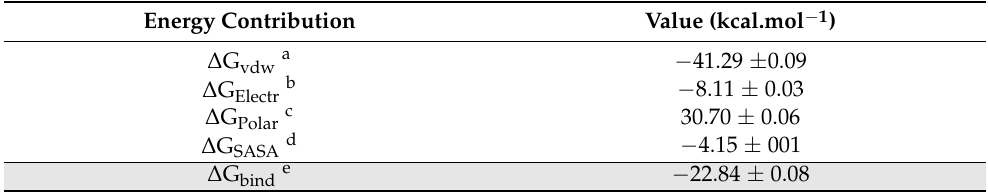
Figure 13. ( A ) 3D-plot for comparison the top-one docking pose and pose after 100 ns MD simulations for hybrid 4a inside the active site of caspase-3 (docking pose in blue and pose post-100-ns MD simulation in red) ( B ) The contributions of individual amino acid residues of caspase-3 to the total binding during MM-PBSA calculation. Table 3. Binding free energy of the complex between 4a and Caspase-3, Δ G in kcal.mol − 1 . Average obtained from 10,001 snapshots MD trajectory using the MM-PBSA method with the g_mmpbsa software.